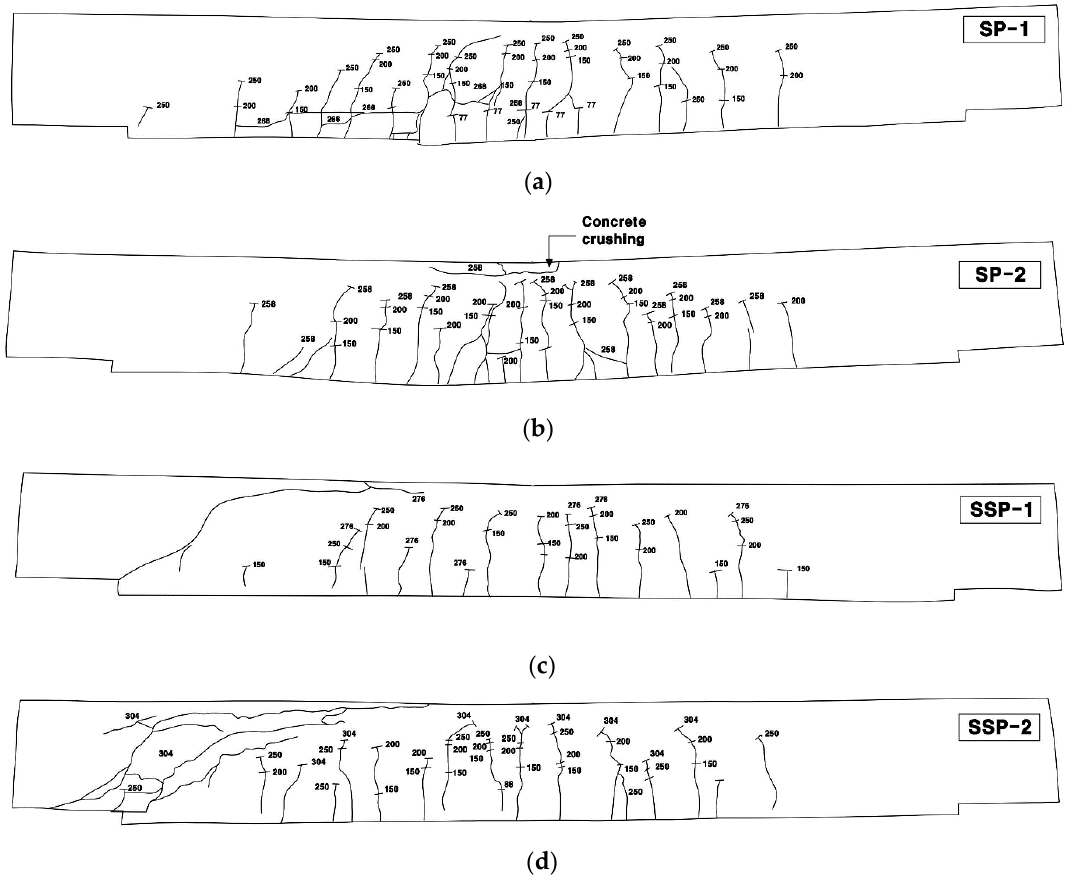
Figure 13. Cracked patterns on the bottom side of specimens after failure (sketch): ( a ) SP-1; ( b ) SP-2; ( c ) SSP-1; ( d ) SSP-2.